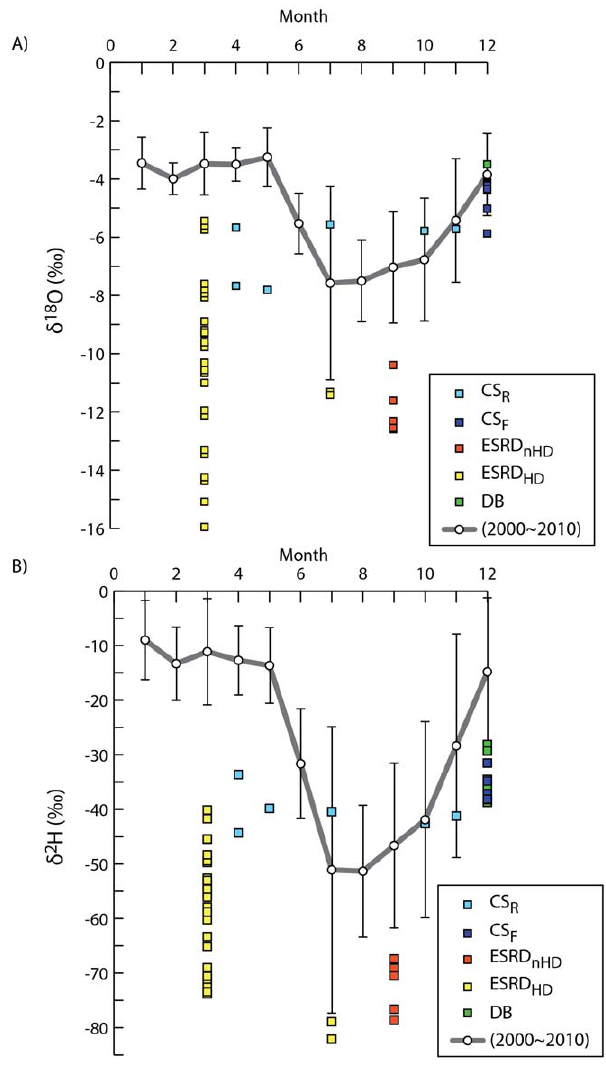
Figure 2. A comparison of stable isotopic water in human blood plasma and monthly mean precipitation in 2000–2010 at Taipei, Taiwan. (A) The mean values of Taipei precipitation in March, July and September from the past 11 years are idiosyncrasies to the d 18 O in blood plasma of the ESRD nHD (100%) and the ESRD HD (100%). This occurrence is observed in the DB and the CS F . 50% of the CS R are corresponding to the precipitation. (B) Both d 2 H and d 18 O in blood plasma of the ESRD nHD , ESRD HD , and CS R are observed in a comparable manner of the monthly precipitation. None of the CS F is corresponding to the precipitation. The d 18 O and d 2 H in blood plasma are indicated by squares, colored as in figure 1. The mean d 18 O and d 2 H in precipitation are indicated by circles, connected by gray lines. Error bars (black vertical lines connected by breaks) represent the standard deviation of the